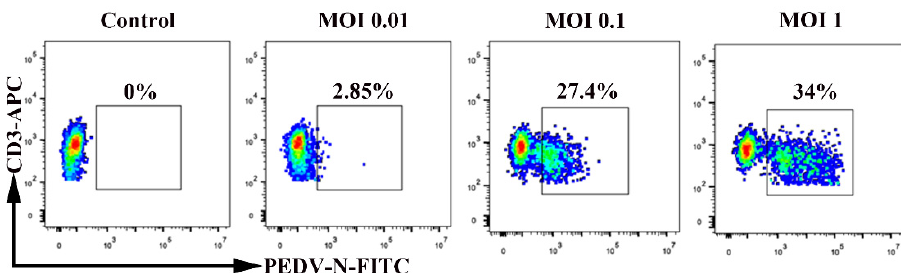
Figure 3. Multiplicity of infection affects the percentage of PEDV + blood-derived CD3 + T cells. Blood-derived CD3 + T cells were inoculated at an MOI of 0.01, 0.1, or 1 with PEDV. Percentages of PEDV-N-positive CD3 + T cells were detected using FACS. FACS: Fluorescence Activated Cell Sorte; MOI: Multiplicity of infection.